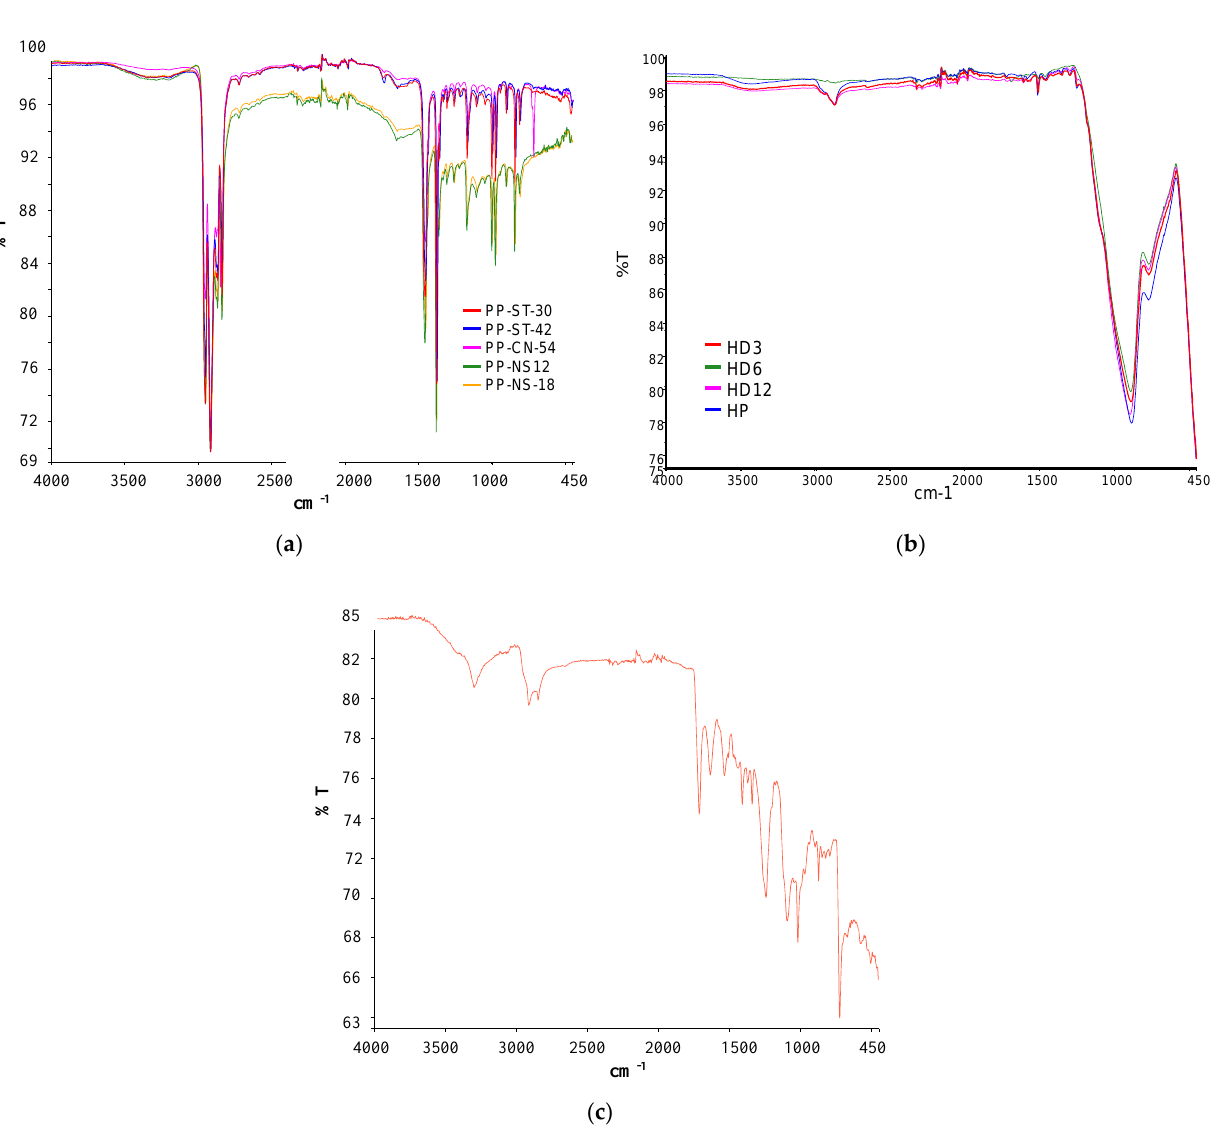
Figure 12. Tensile strength of polypropylene fibers.